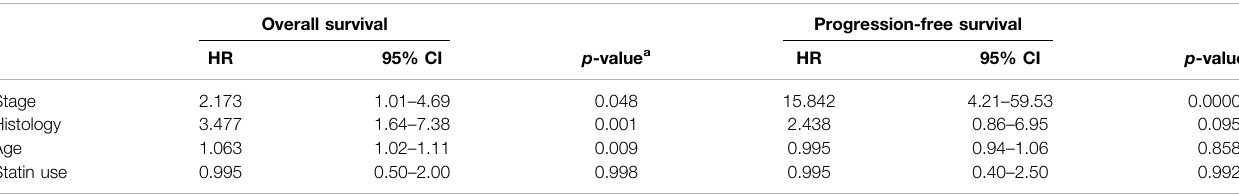
TABLE 3 | The results of multivariate analysis. Overall survival Progression-free survival p -value